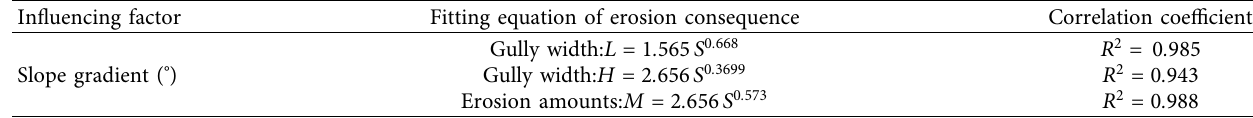
Table 5: Effect of slope gradient on erosion disaster